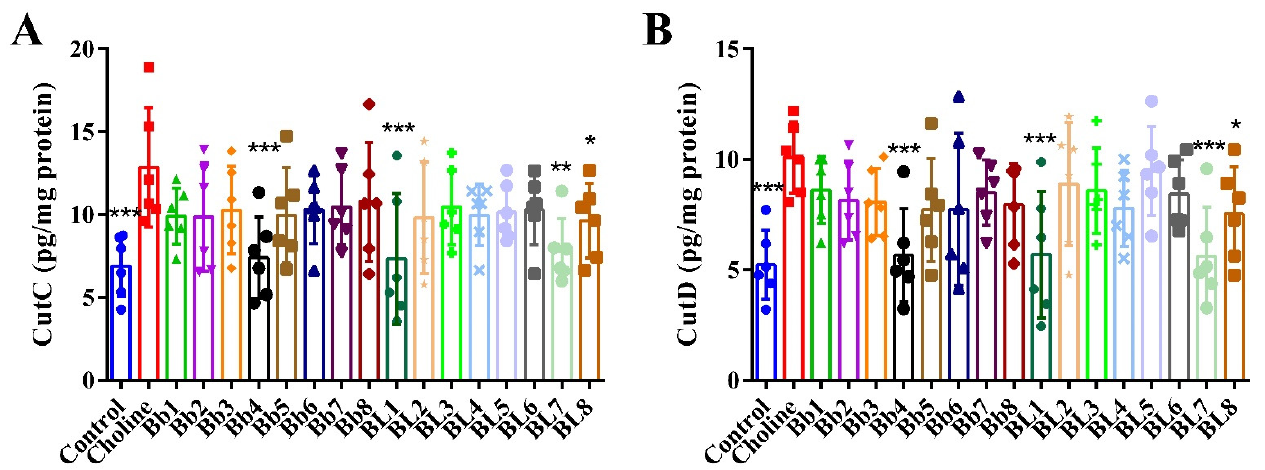
Figure 6. Some Bifidobacterium strains decreased the protein levels of cecum CutC and CutD in mice to some extent: ( A ) CutC levels in cecum, ( B ) CutD levels in cecum. Values are mean ± SD, six mice per group. * p < 0.05, ** p < 0.01, *** p < 0.001 versus the choline group.